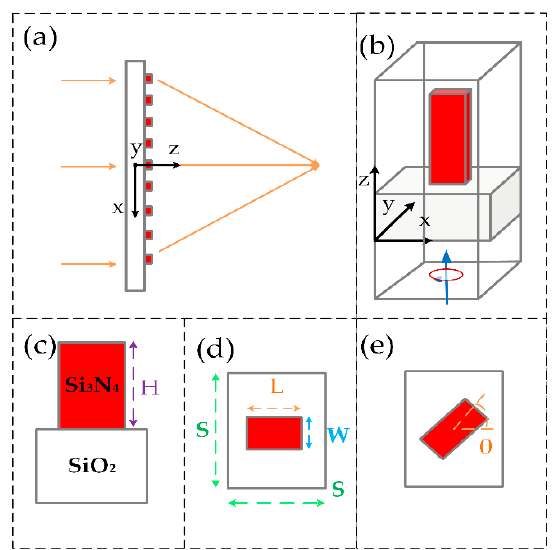
Figure 1. Design of the metalens. ( a ) Schematic of the metalens and its building block, the Si 3 N 4 nanorod. ( b ) Si 3 N 4 nanorod on SiO 2 substrate. ( c ) and ( d ) side and top views of the unit cell showing the height, width, and length of the nanorod having unit cell dimensions S × S. ( e ) By the rotation of the nanorod, the required phase is imparted by an angle of θ following the geometric Panchratnam–Berry phase. The incident circularly polarized light can be partly converted into inversed circularly polarized light that has the geometric phase according to the PB phase method. In our design, the incident light was left circularly polarized light (LCP) and the transmitted light was right circularly polarized light (RCP). In case of incident LCP light, for a nanorod with rotating angle θ the generated phase shift